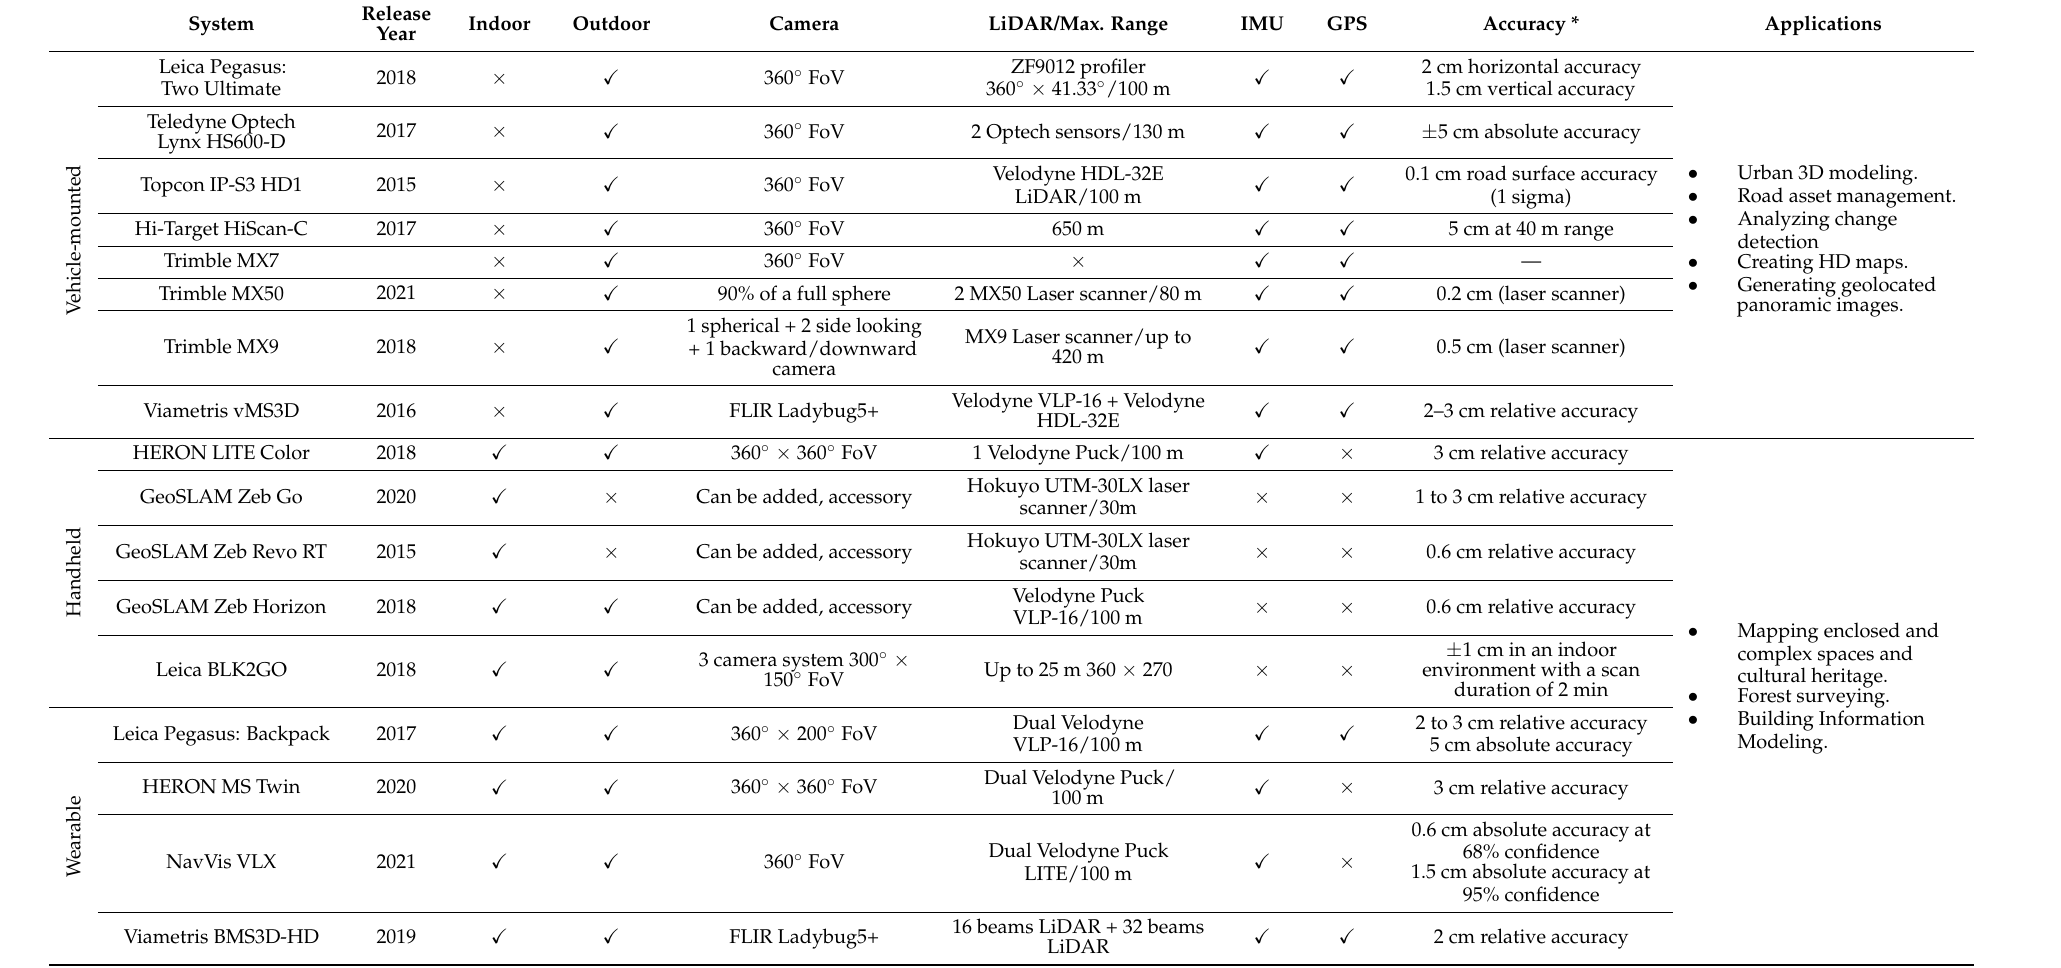
Table 4. Specifications of different